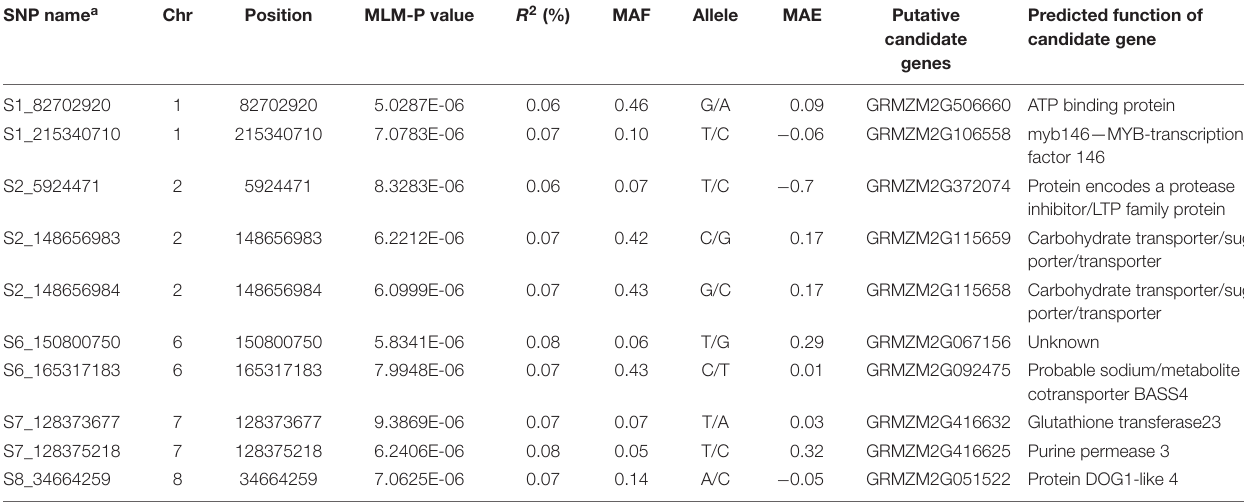
FIGURE 3 | (A) Manhattan and quantile–quantile plots of a mixed linear model for GLS resistance in the IMAS association mapping panel evaluated in four environments. The dashed horizontal line depicts the significance threshold ( P = 9.5 × 10 - 6 ). The X -axis indicates the SNP location along the 10 chromosomes, with chromosomes separated by different colors; Y -axis is the -log10( P observed) for each analysis. (B) Quantile–quantile plots. TABLE 4 | List of significant SNPs and candidate genes associated with GLS resistance in the IMAS association panel evaluated in four